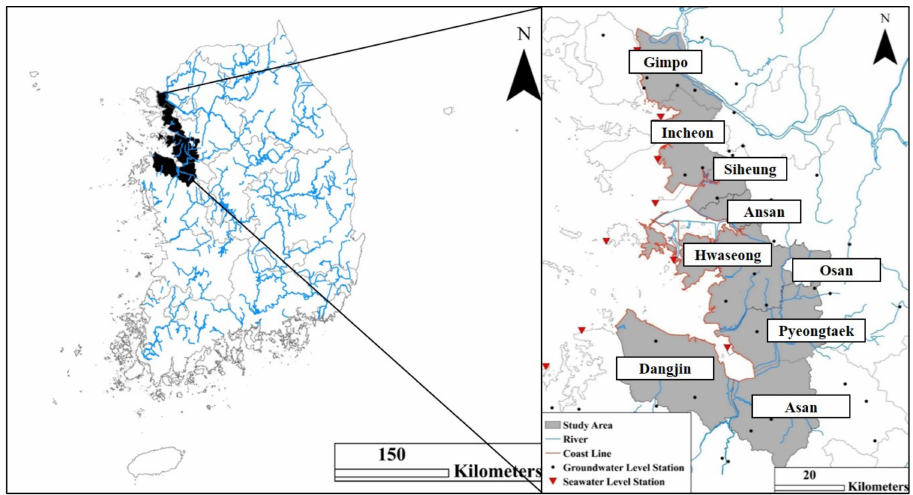
Figure 3. Study area in the western coastal region of South